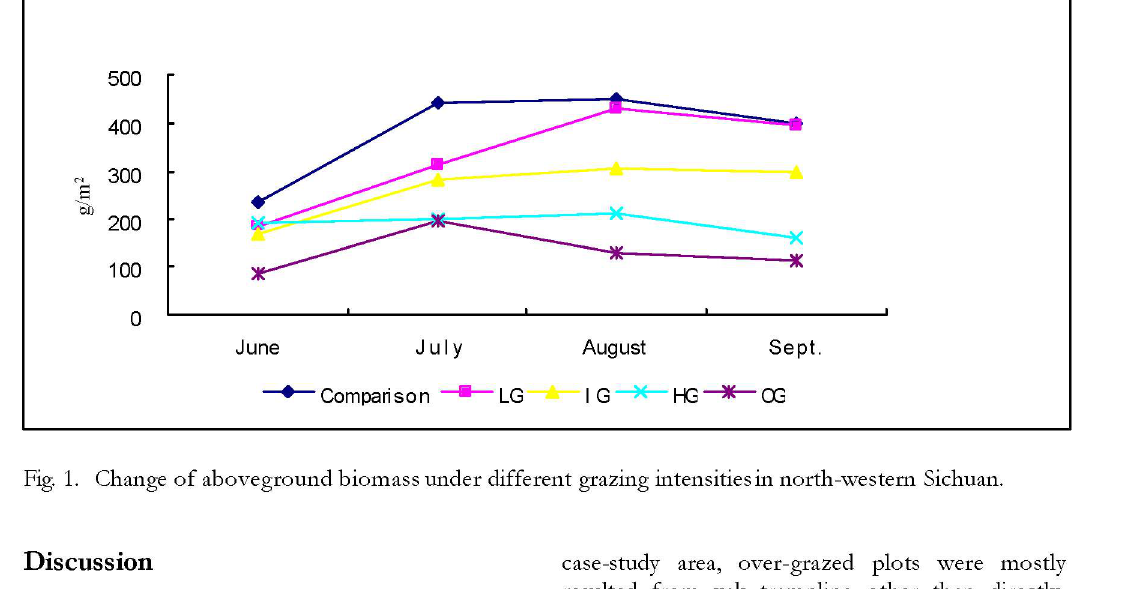
Fig. 1. Change of aboveground biomass under different grazing intensities in north-western